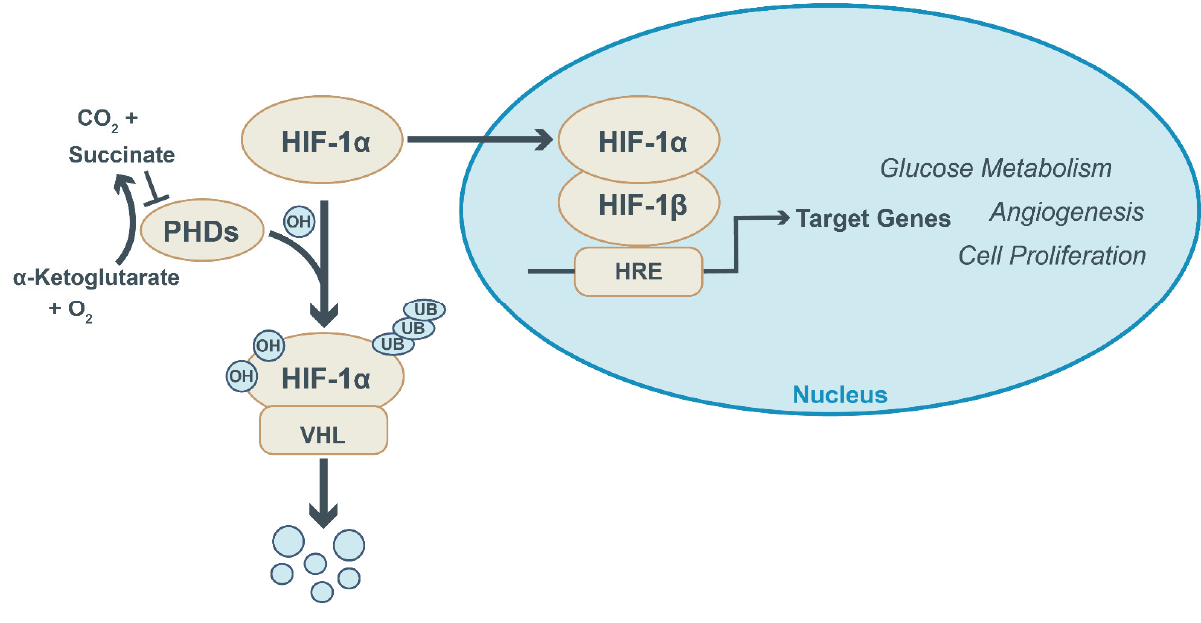
Figure 2. HIF-1a signaling and regulation. Under normoxic conditions, prolyl hydroxylase enzymes (PHDs) hydroxylate HIF-1a and mark it for degradation by the von Hippel–Lindau E3 ubiquitin